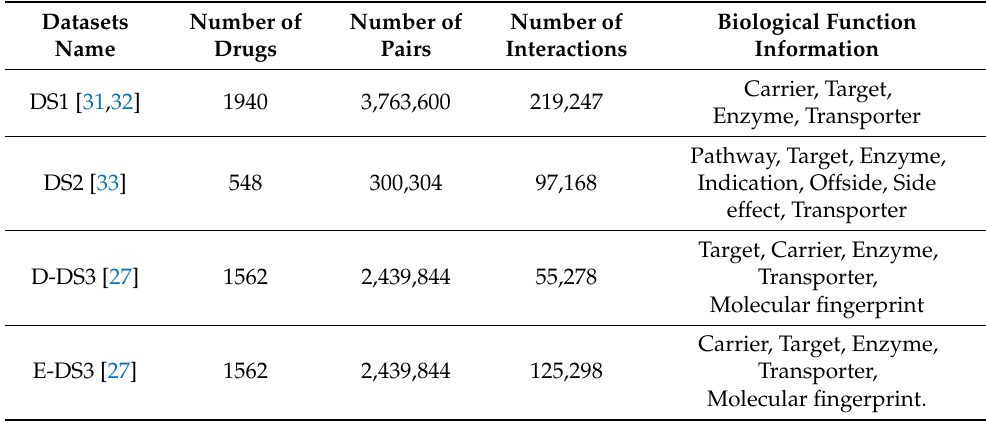
Table 1. The feature description and interaction details of the four